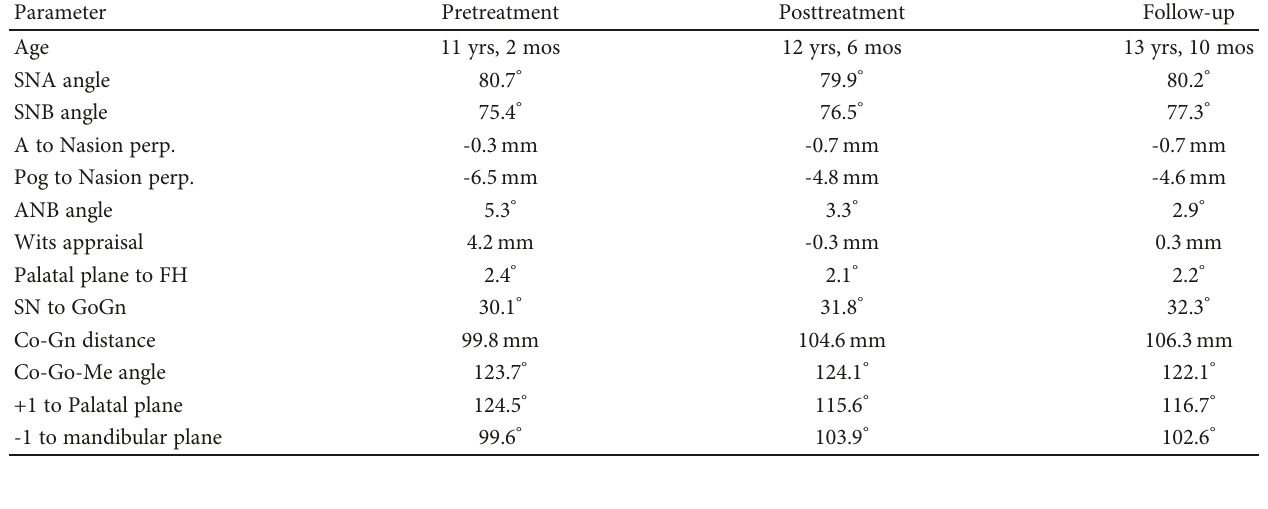
Table 2: Cephalometric data of Case 2.